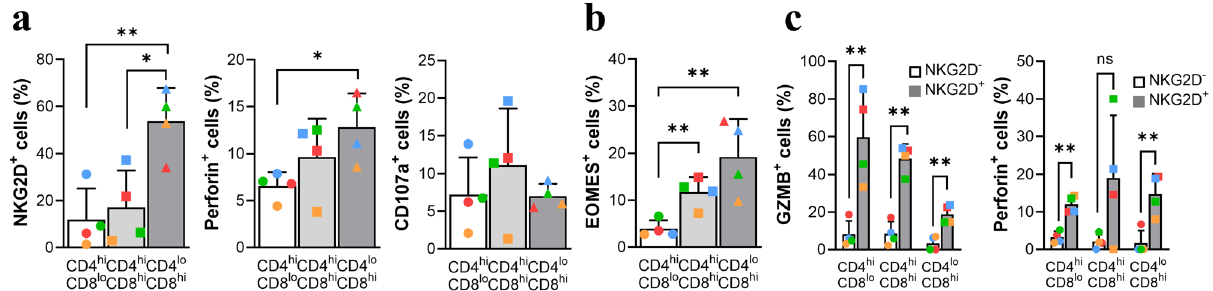
Figure 6. Phenotype and cytokine profile of the CD4 lo CD8 hi fraction. ( a ) Percentage of NKG2D + , perforin + , and CD107a + cells within each DP T cell fraction. ( b ) Percentage of EOMES + cells within each DP T cell fraction. ( c ) Comparison of granzyme B + and perforin + cells between NKG2D + and NKG2D - DP T cell fractions. Cytokine production was measured after stimulation of PBMCs with PMA/ionomycin for 4 h. Data are expressed as the mean ± SDs (n = 4). Red dots on the bar graph represent data from the monkey used for scRNA-seq analysis. * p < 0.05; ** p < 0.01; ns not significant, GZMB granzyme